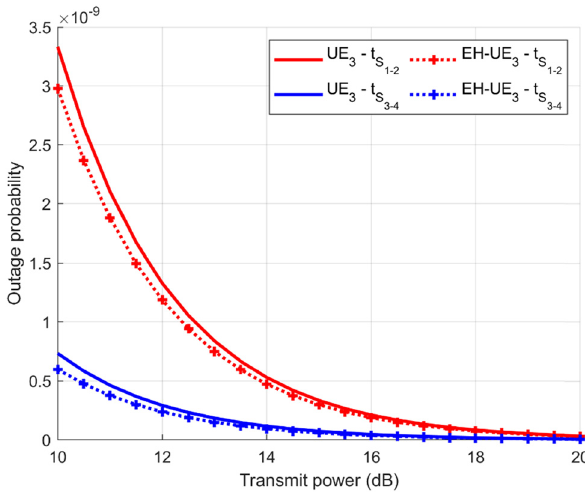
Figure 5: Outage probability of user 3.